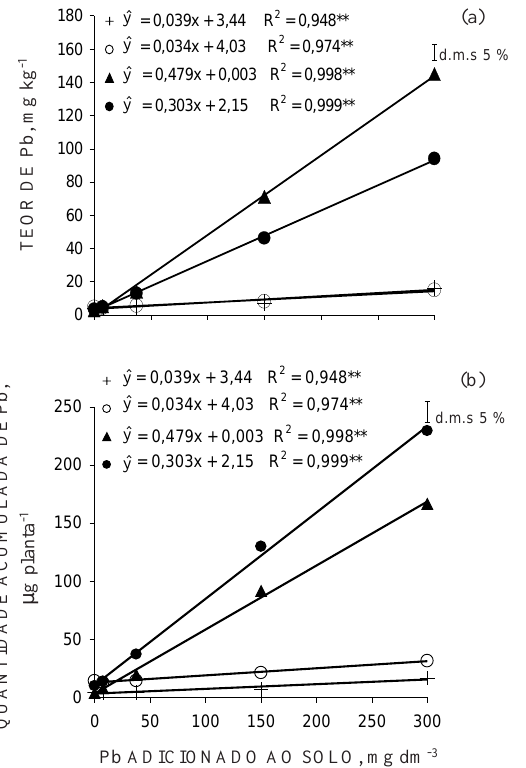
Figura 2. Teor (a) e quantidade acumulada (b) de Pb na parte aérea da soja, considerando a dose = de Pb adicionada ao solo ( com FMA e V 1 63 %; sem FMA e V = 63 %; com FMA e V = 1 2 = 82 %). Valor do d.m.s a 82 %; + sem FMA e V 2 5 % para comparar entre os FMAs e as V % dentro de cada dose de Pb (n.s: não- significativo; ** p < 0,01).